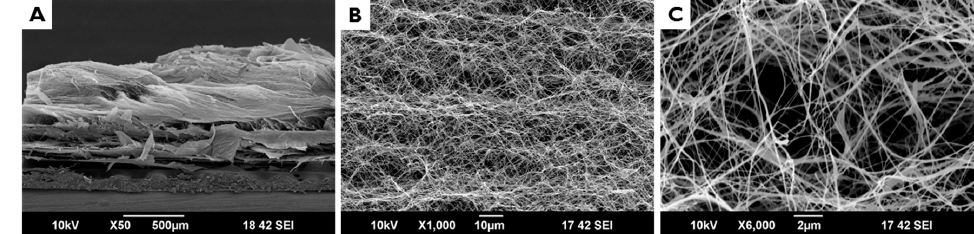
Figure 2. Cross sectional SEM images of non-pressed, electron beam irradiated BC membrane (EI-BCM) (Original magnification: 50× ( A ); 1000× ( B ); and 6000× ( C )). EI-BCMs had a porous structure comprised of entangled nanofibers.